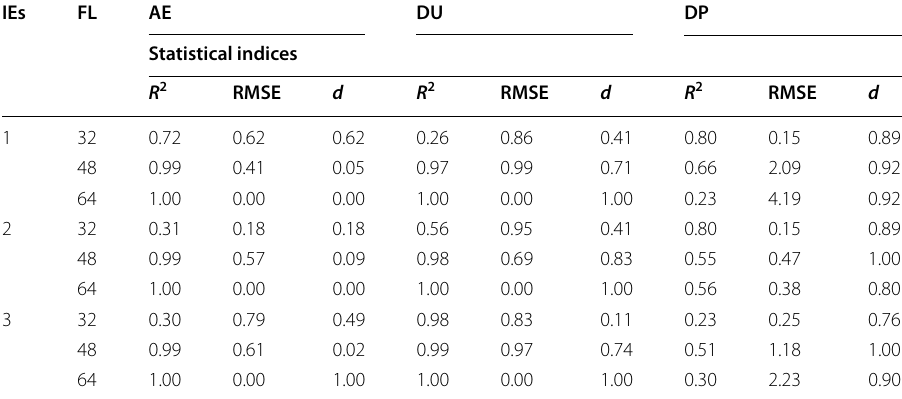
Table 10 Statistical indices of improved furrow irrigation